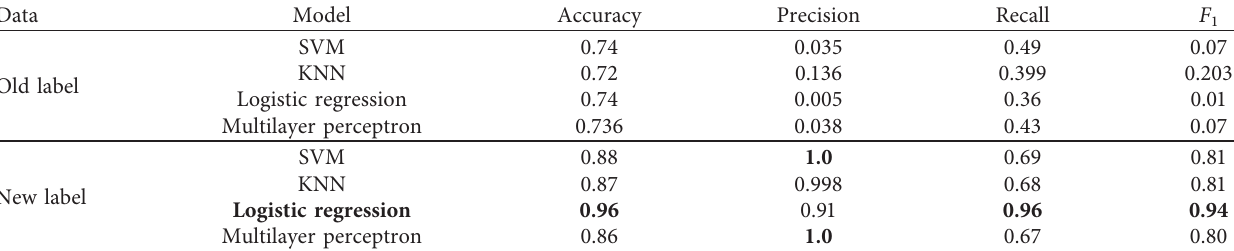
Table 18: Performance of different models with different labels.